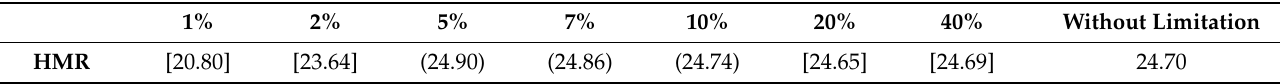
Table 6. Statistics of wind turbine hourly mean revenue (HMR) in EUR with and without limitations. The value higher than the associated limitless one is in round brackets and the value lower that the associated limitless one is put in square